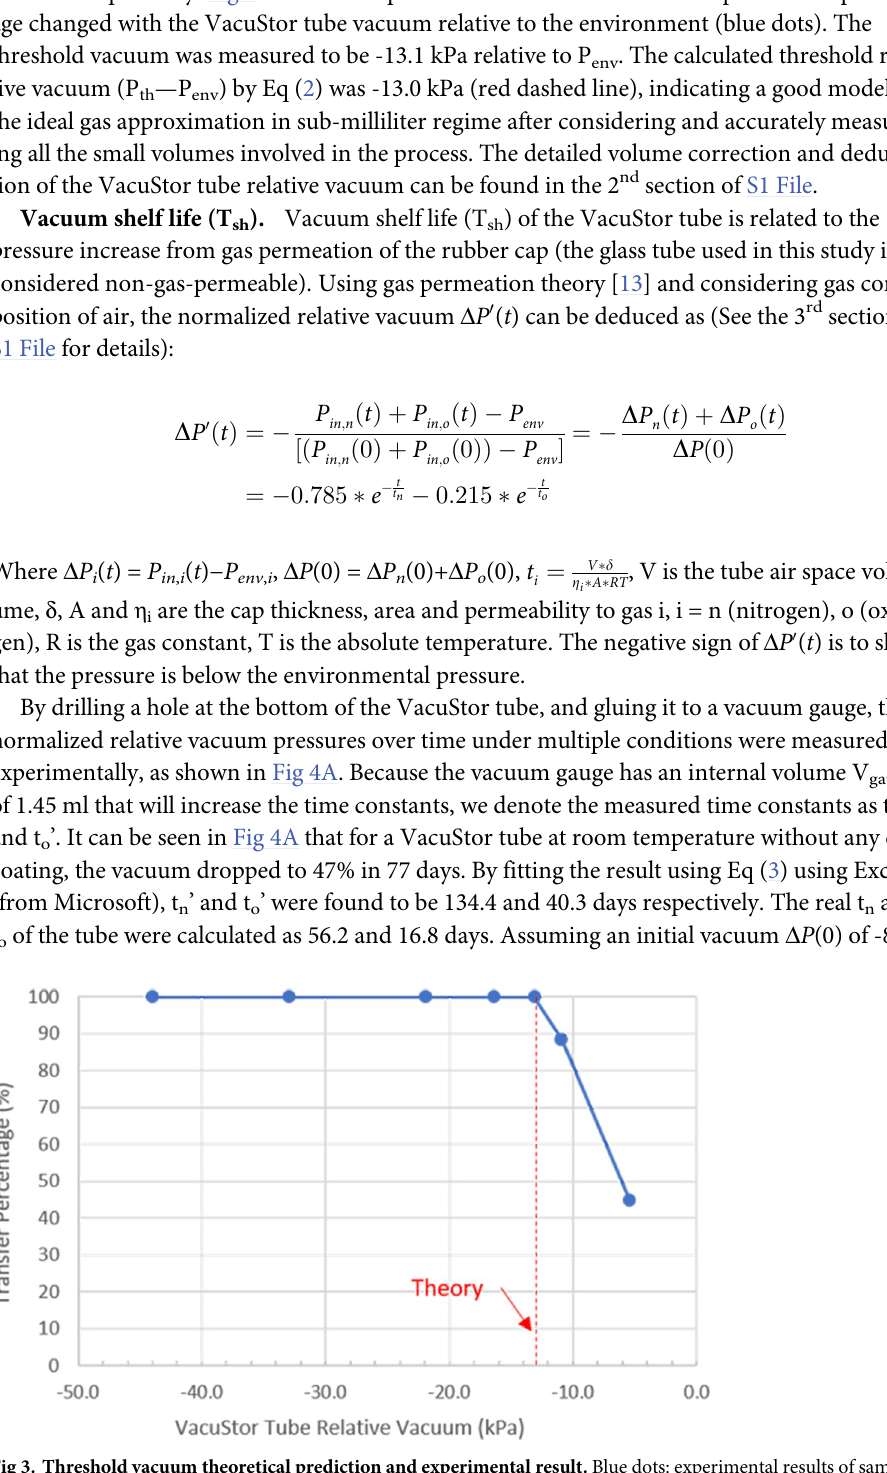
Fig 3. Threshold vacuum theoretical prediction and experimental result. Blue dots: experimental results of sample transfer percentage vs. VacuStor tube relative vacuum; red dashed line: relative threshold vacuum prediction by Eq (2).